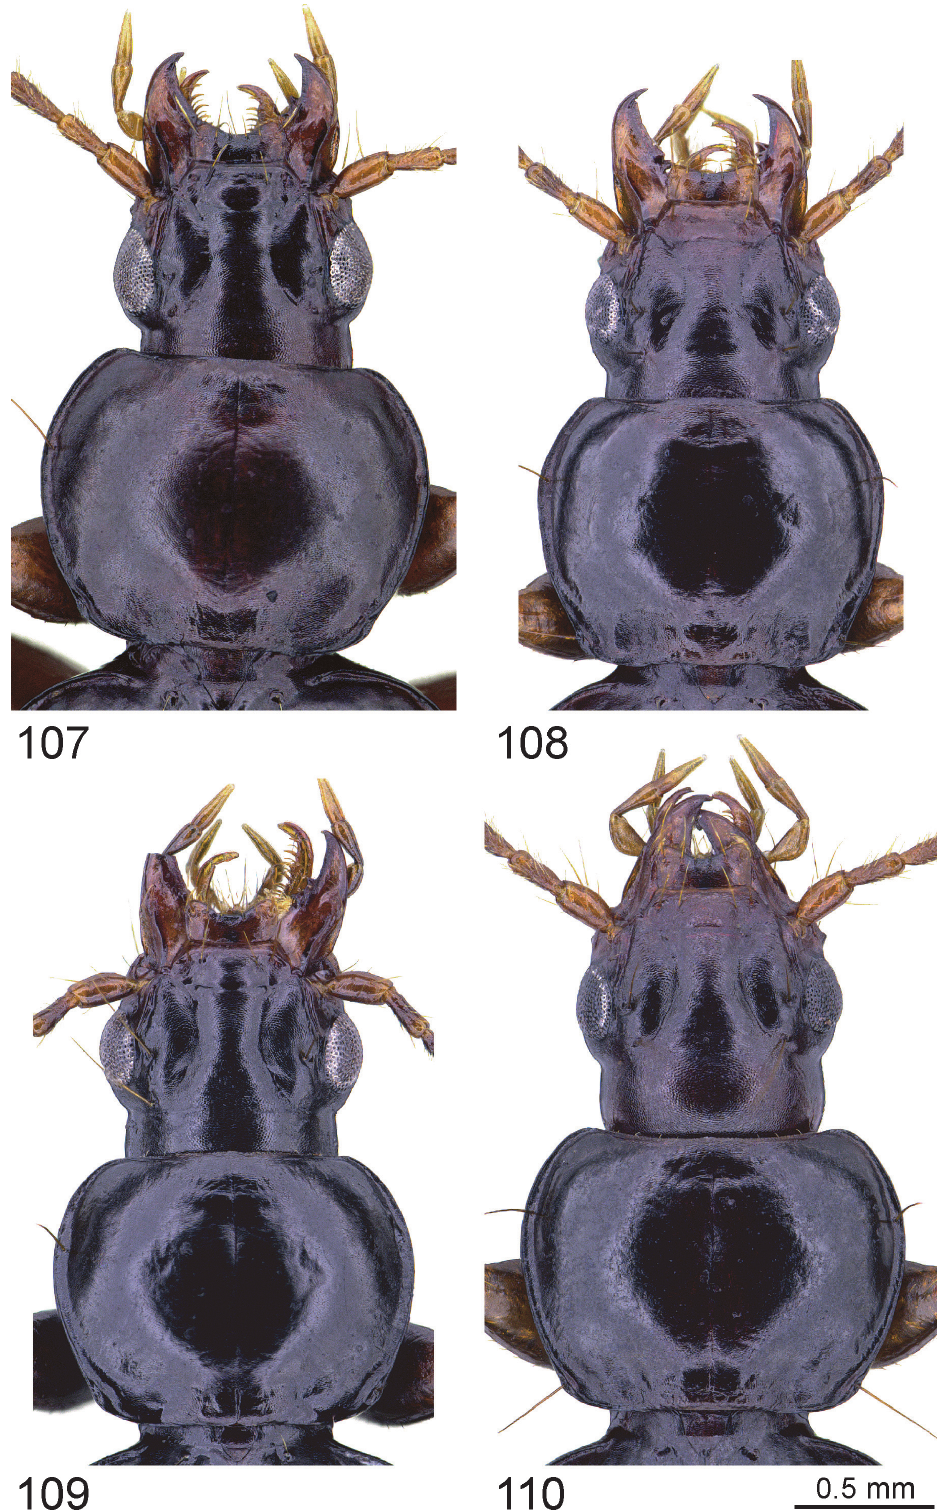
Figs 107–110. Trechus spp., head, pronotum. 107 . T. haggei sp. nov., paratype, ♂. 108 . T. tragelaphus sp. nov., holotype. 109 . T. nigrifemoralis , sp. nov., holotype. 110 . T. balesilvestris , sp. nov.,